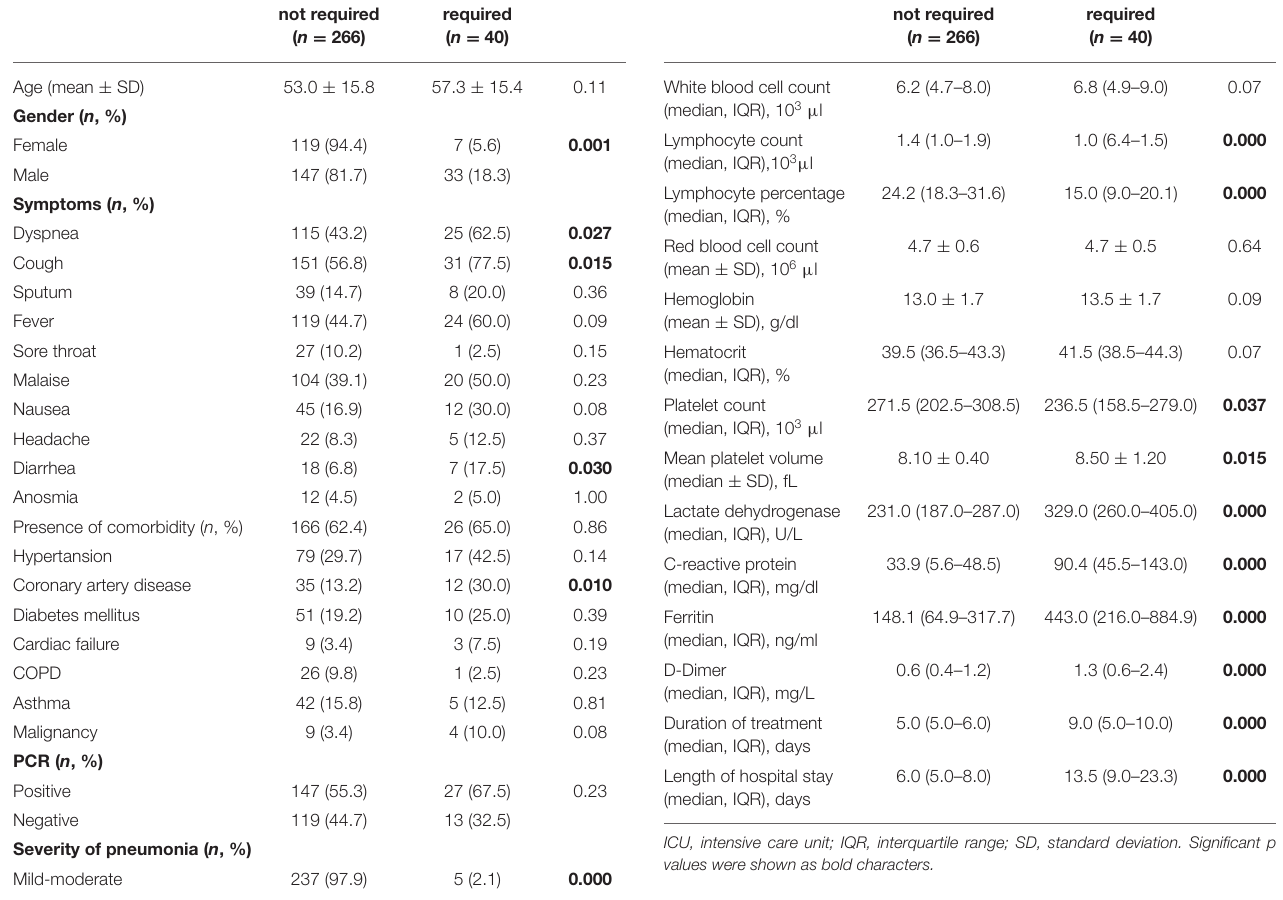
TABLE 2 | Comparison of patients according to the basal laboratory findings on admission, duration of treatment, and length of hospital stay.